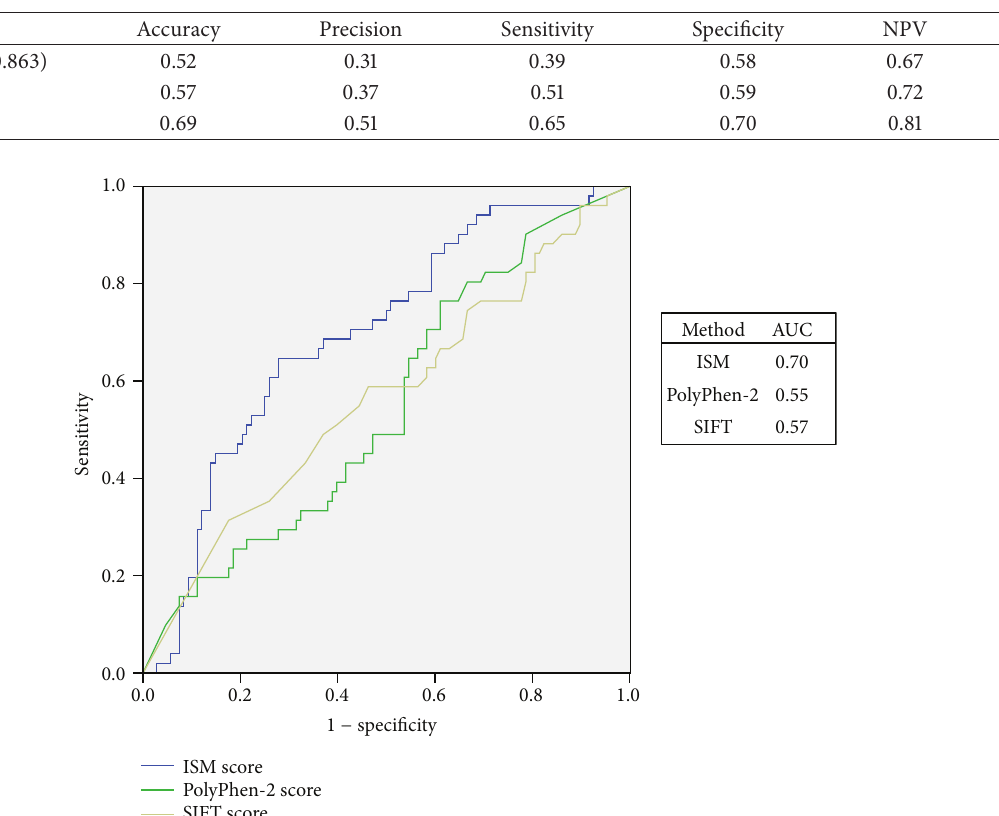
Table 4: Performance statistics of PolyPhen-2, SIFT, and ISM binary classification of AASs outside CFDs.